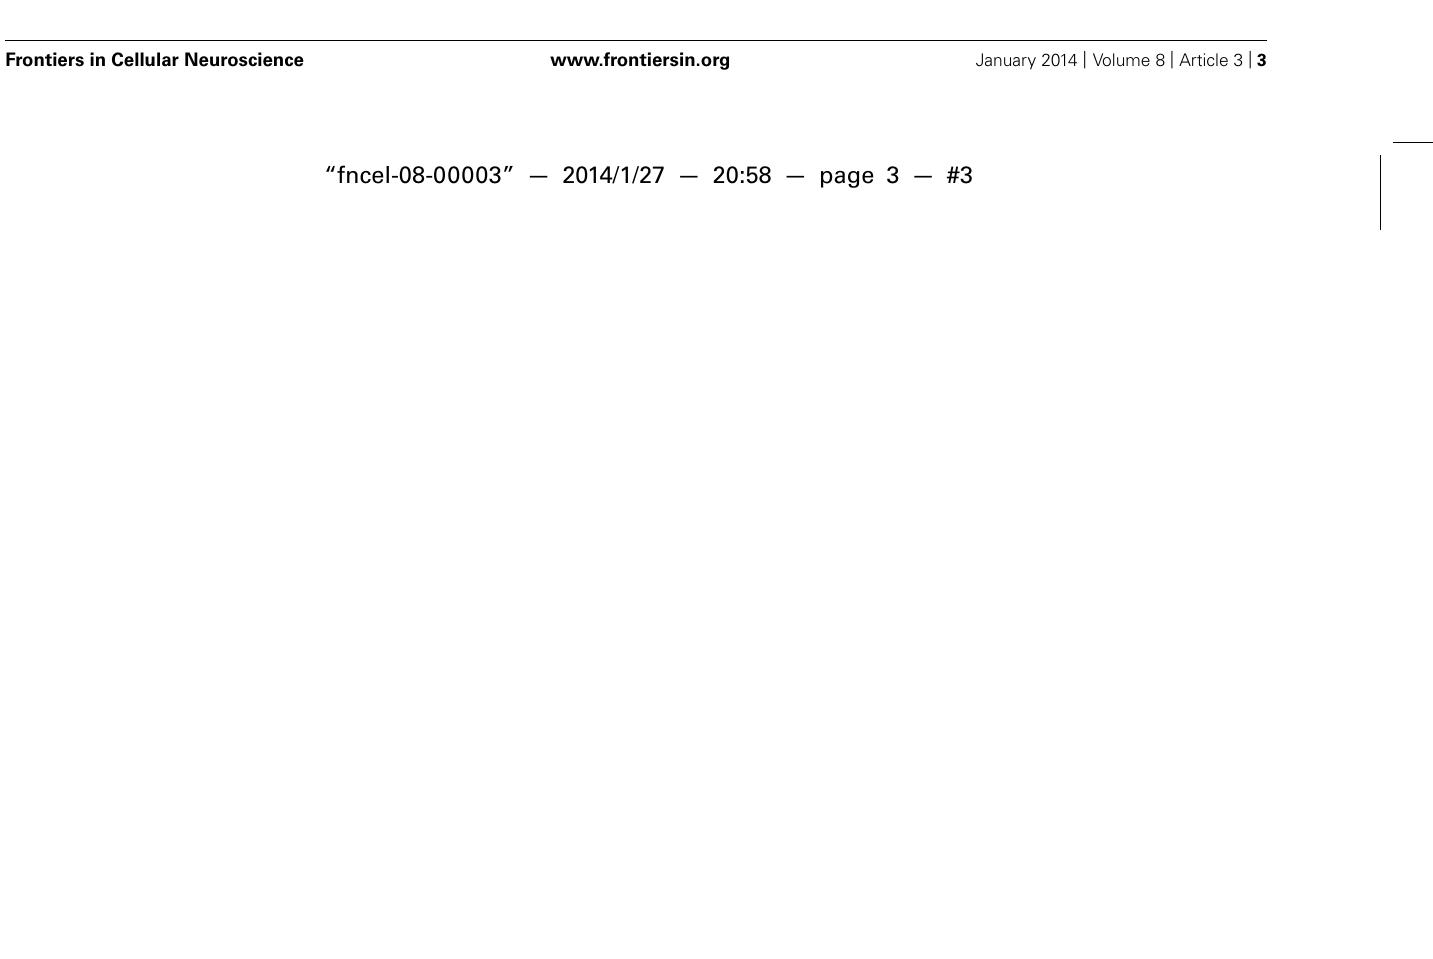
entire molecule (left panels) and the selected regions (right panels).The residues comprising the peptide segments fromV47–V61 and K326–N338 are presented in green; double arrows and numbers show average distances encompassing the ion entrance point.TheTable within the insets summarizes the ion radii of physiologically permeable ions through P2X4R and cadmium ions in hydrated and non-hydrated